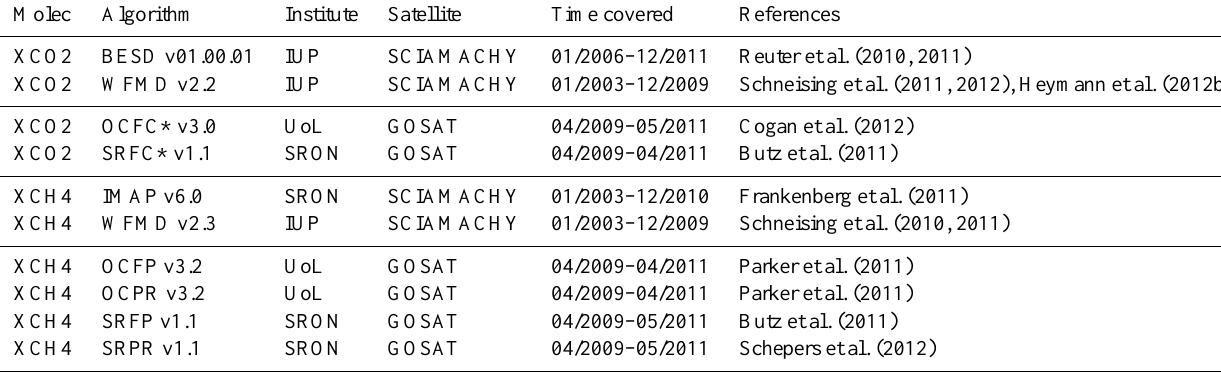
Table 1. List of all GHG-CCI algorithms inter-compared in this study, their time coverage and references. Molec